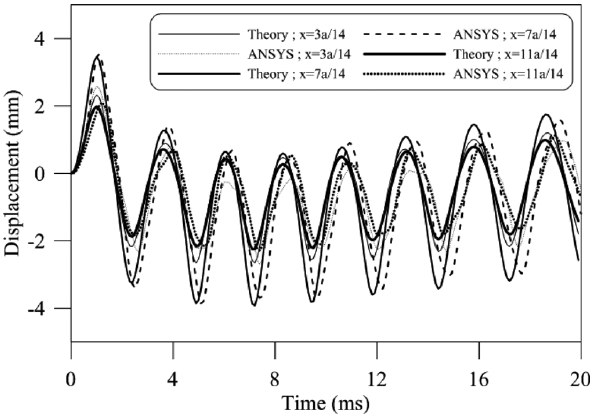
Fig. 20. The displacement-time histories of the simply-supported tapered laminated plates ( β = 1.2) for the stacking sequence [UCBGBC] S with [60/30/0] S